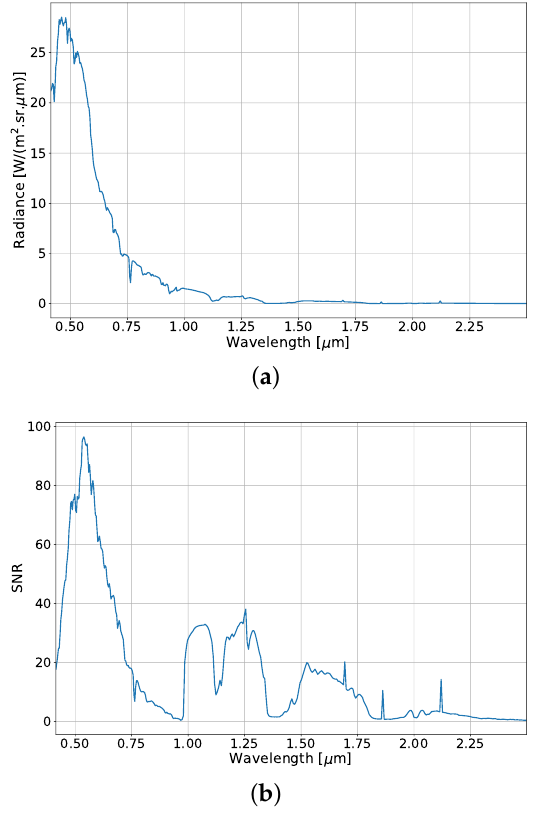
Figure 2. Water pixel: ( a ) Mean radiance spectrum; and ( b ) associated signal-to-noise ratio. The reference simulation state corresponded to seawater reflectance, a background aerosol model set to the MODTRAN rural mode with a visibility of 15 km. The scattering aerosol plume modal radius was set to 0.15 µ m and the AOT to 0.1, respectively. The coefficients α and β were set to 0.0 and 0.3, respectively. The reference state was closed to the observation case. From the reference state, we estimated the retrieval uncertainties due to a nominal variation (or uncertainty) of the forward model inputs or assumptions. Estimated retrieval uncertainties corresponding to the HYSPEX noise were around 0.0024 for AOT and 0.001 µ m for the modal